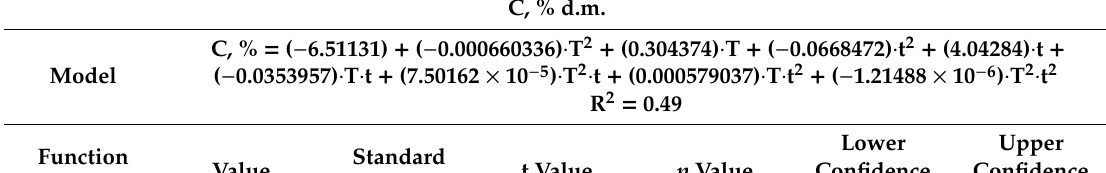
Table A6. The statistical parameters of polynomial regression analysis of the influence of SS torrefaction temperature and residence time on the C content in biochars.